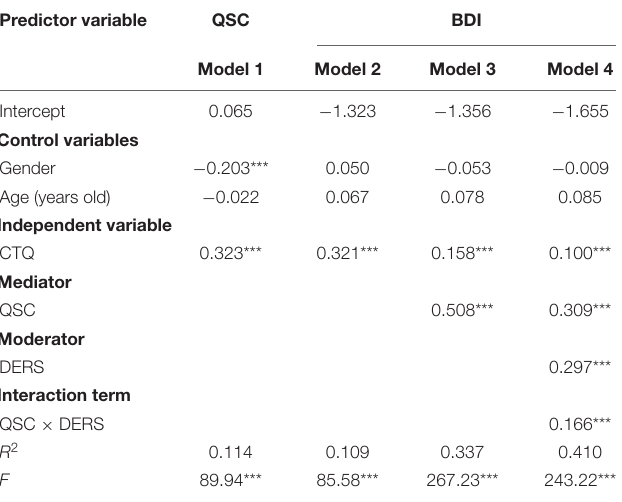
TABLE 4 | Results of moderated mediation analyses.